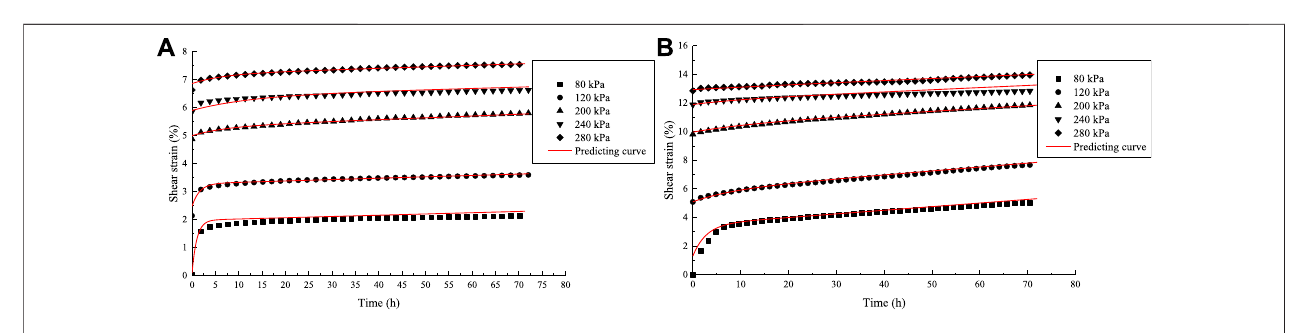
FIGURE 5 | Prediction results of the Burgers model (A) w = 3.8%, (B) w = 16.4%.